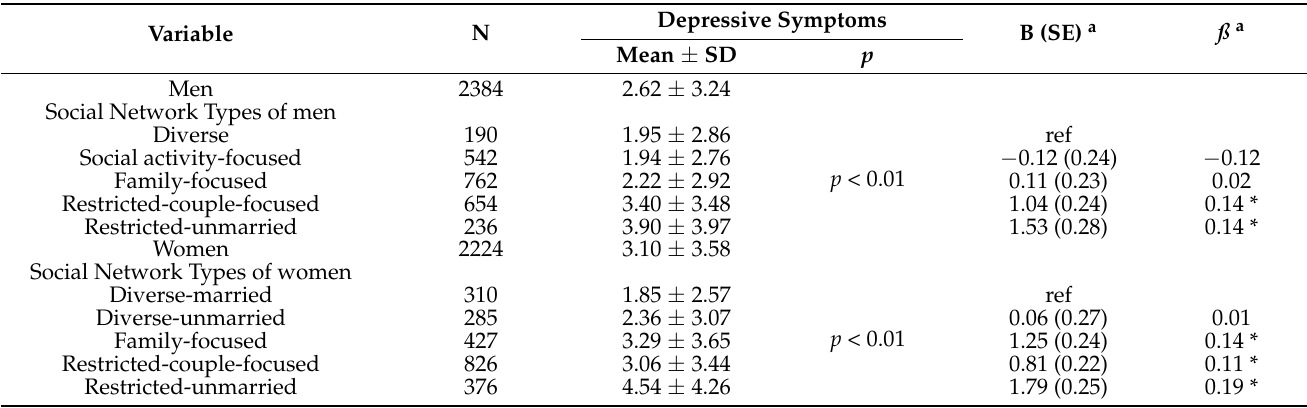
Table 4. Scores of depressive symptoms and multiple regression for depressive symptoms among older men ( n = 2384) and women ( n = 2224) in the 2017 Korean Living Profile Survey of Older People. Variable